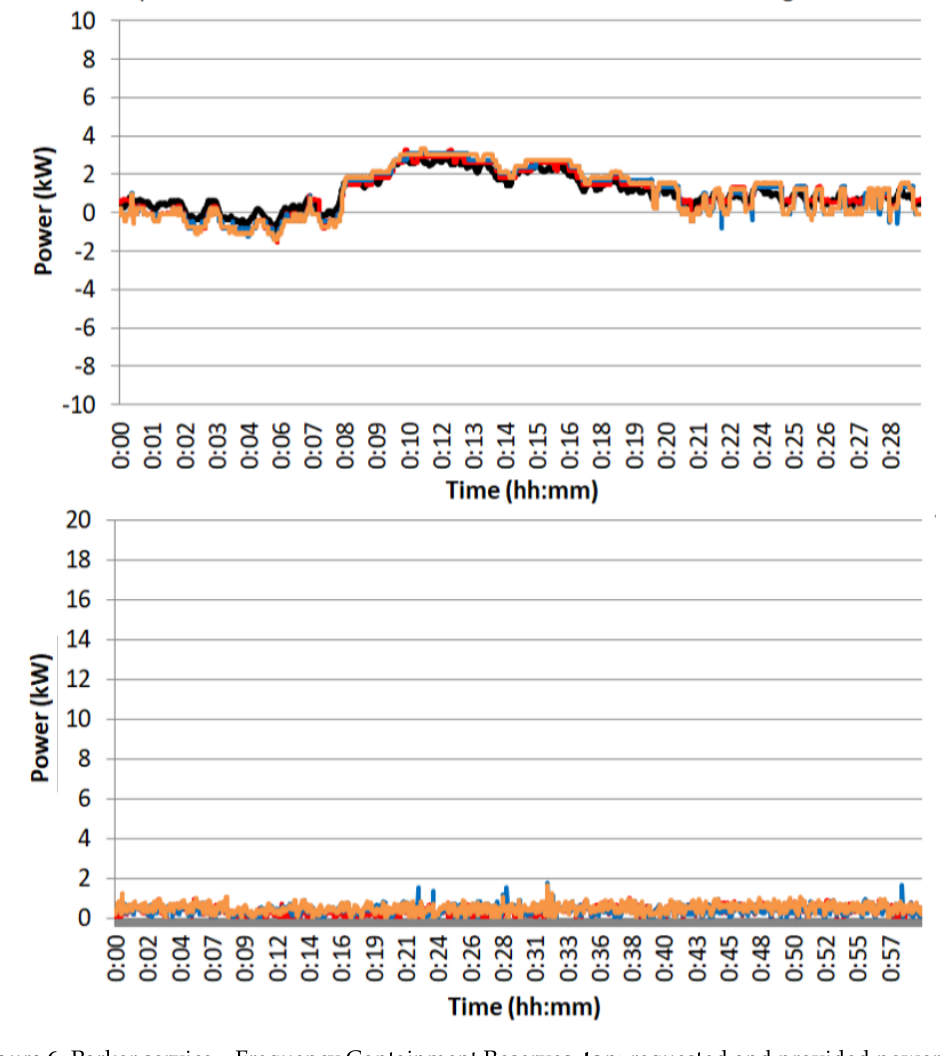
Figure 6. Parker service—Frequency Containment Reserves, top : requested and provided power for service, bottom : absolute difference between requested and provided